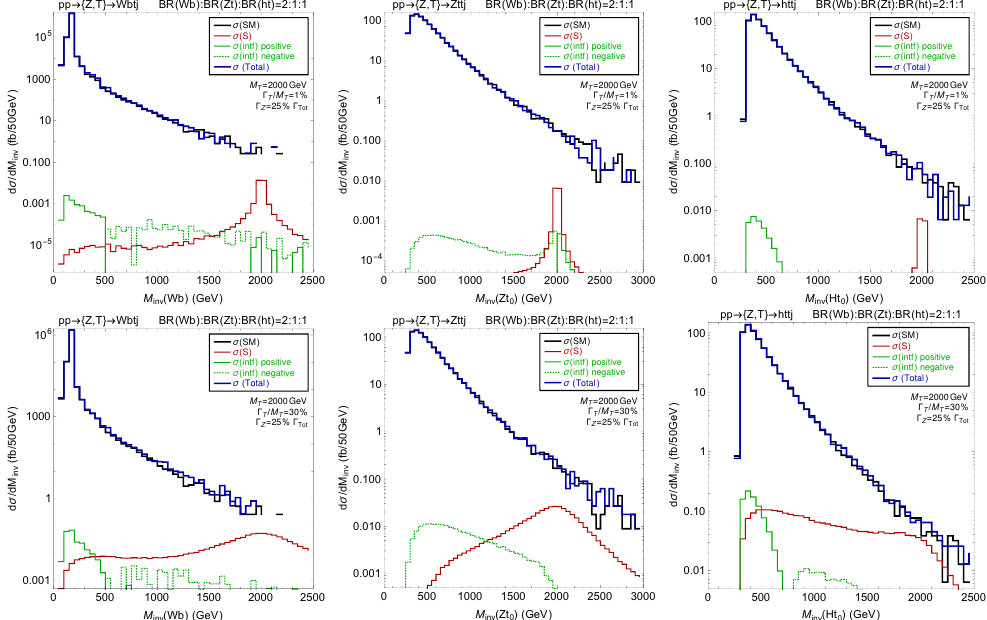
Figure 23 . Same as in figure 22 for M T = 2 TeV